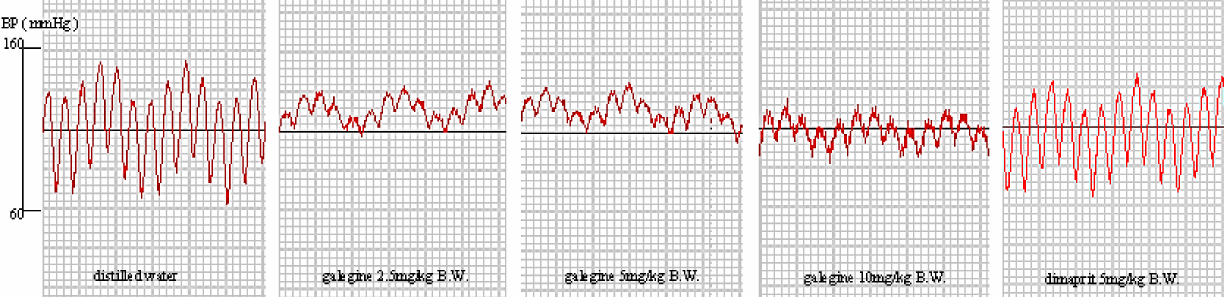
Figure 5. Effect of galegine on blood pressure of pentobarbital-anesthetized hypertensive rats. n =